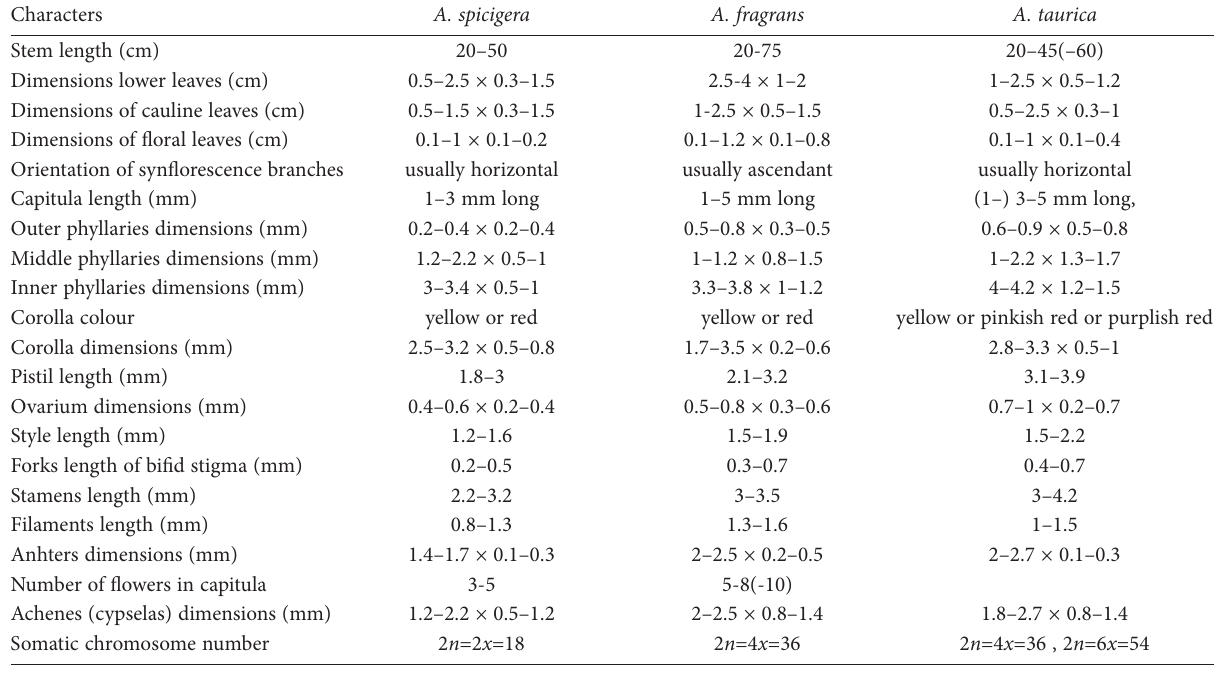
Table 5. Comparison in terms of key features that distinguish of the species of A. spicigera , A. taurica and A. fragrans